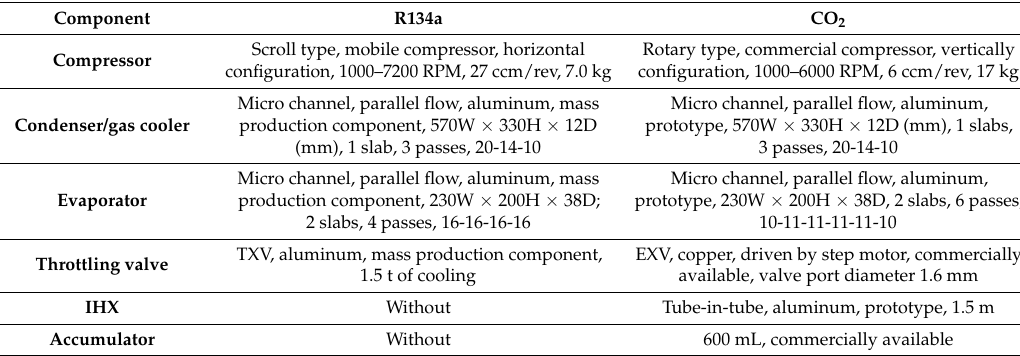
Figure 2. Schematic diagrams of the CO 2 MAC system and R134a MAC system. Table 1. The specification of the R134a and CO 2 AC system components.